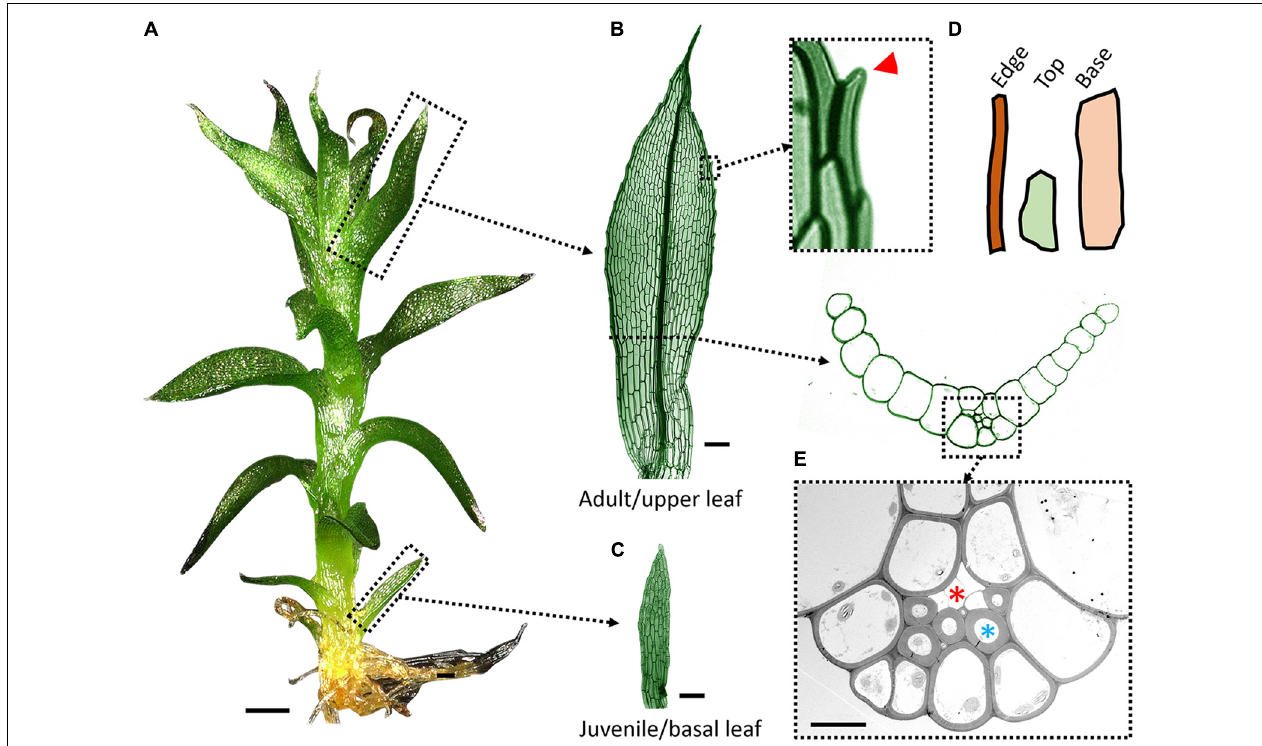
FIGURE 1 | Leaf anatomy in P. patens . (A) A leafy shoot (or gametophore) with juvenile and adult leaves from the base to the top. (B) Adult (upper) leaf has a multicellular midrib and lanceolate shape. The leaf margin is magnified to show marginal serrations (red arrowhead) formed by cell tip outgrowths. (C) First juvenile leaf is composed of a single cell layer and has a rectangular shape. (D) Three cell shapes are commonly identified in adult leaves: long and narrow cells on the edge; smaller and more isodiametric cells close to the tip (top); long and broad cells near the base (based on Dennis et al., 2019). (E) TEM cross-section image of a midrib cell bundle with thick-walled stereids and thin-walled hydroids (marked with blue and red asterisk respectively). Scale bars: 200 µ m in (A) ; 50 µ m in (B,C) ; and 10 µ m in (E)